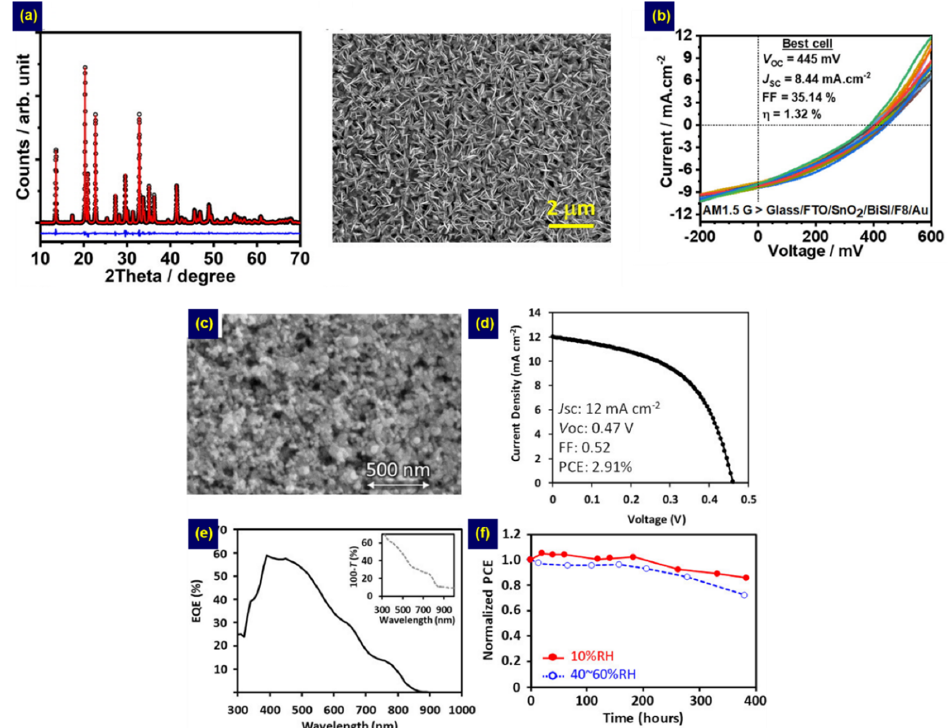
Figure 3. Images and plots for Sb/Bi chalcohalides fabricated by the one-step method based on the spin-coating technique showing: ( a ) structure and surface morphology; ( b ) photovoltaic device performance for BiSI films fabricated by Tiwari et al. [46]. Adapted with permission from ACS Appl. Energy Mater. 2019 , 2 , 3878–3885. Copyright 2019 American Chemical Society [46]. ( c ) Surface morphology image of Sb 2 S 3 -containing SbSI; ( d – f ) the device performance. Adapted with permission